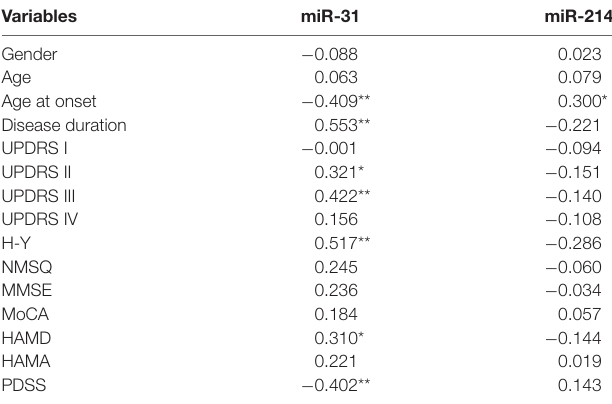
TABLE 2 | Associations between serum miRNAs and clinical characteristics in dnPD and aPD patients by Spearman’s rank correlation analysis. Variables